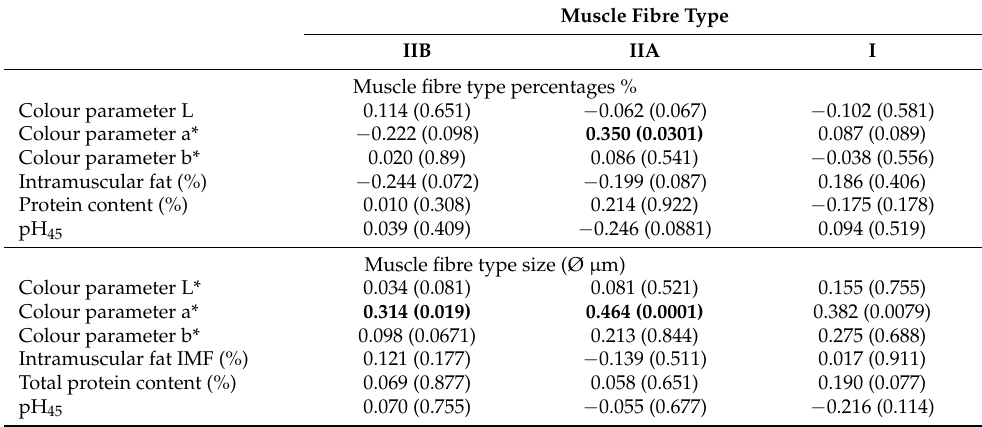
Table 5. Correlation coefficients I between quality characteristics of raw meat m. longissimus thoracis and muscle fibre type percentage and muscle fibre type